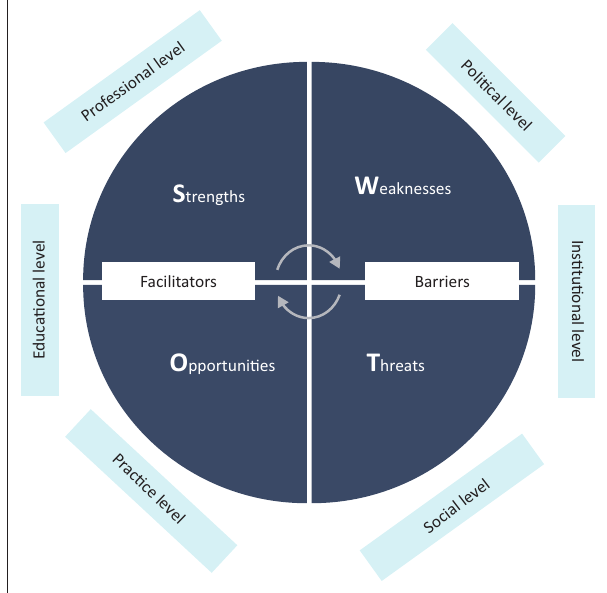
FIGURE 1: Conceptual strengths, weaknesses, opportunities, threats framework adapted for this study.